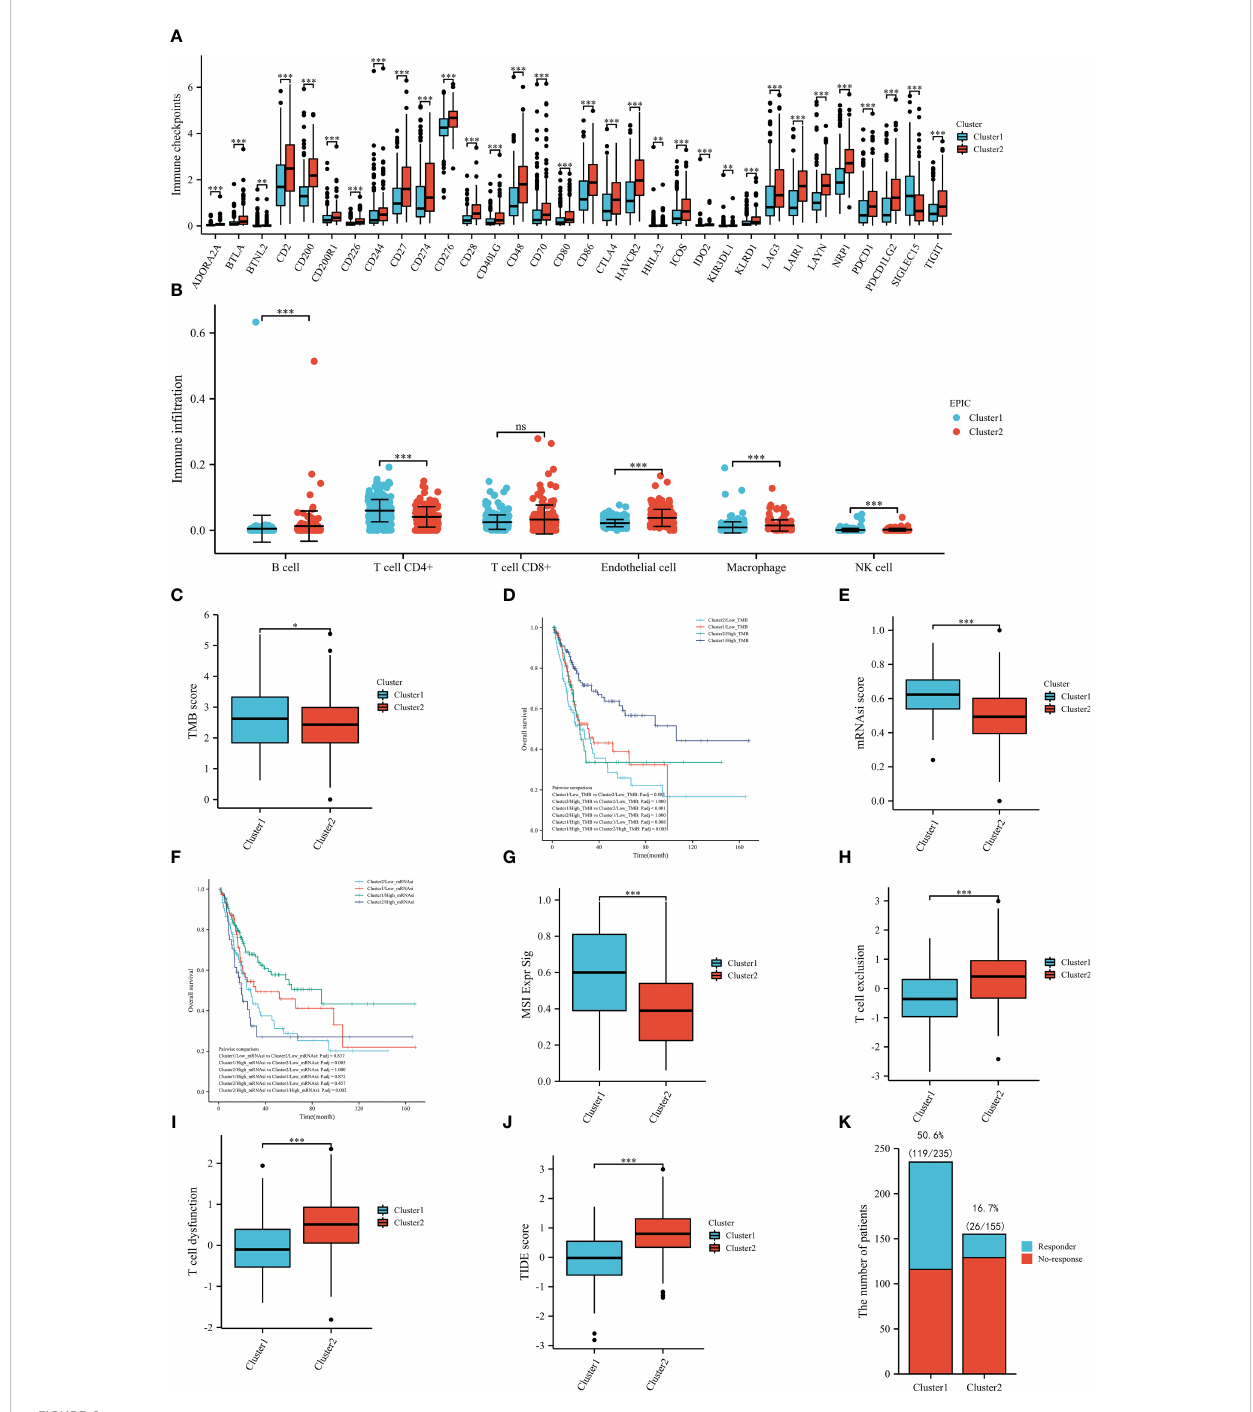
FIGURE 6 Immune-related analysis based on TCGA dataset: immune checkpoints (A) , immune in fi ltration (B) , the tumor mutational burden between the clusters (C) , the overall survival in groups (D) , the stemness index between the clusters (E) , the overall survival in groups (F) , the MSI Expr Sig score in the clusters (G) , the T-cell exclusion score between the clusters (H) , the T-cell dysfunction score between the clusters (I) , the TIDE score between the clusters (J) , the number of the patients with or without response to immunotherapy between the clusters (K) . TMB, tumor mutational burden; mRNAsi, stemness index. ns: P ≥ 0.05; *, P< 0.05; **, P<0.01; ***,